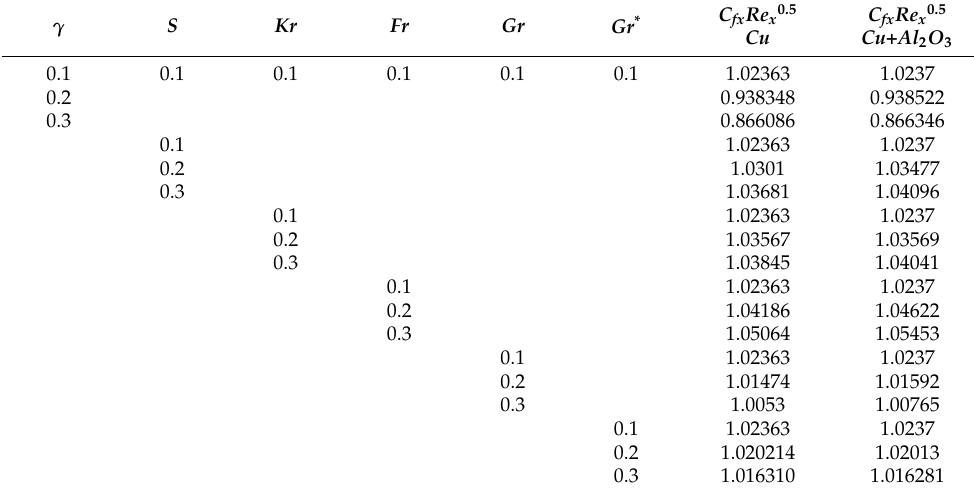
Table 3. The combination of quantitative data versus a set of variables.